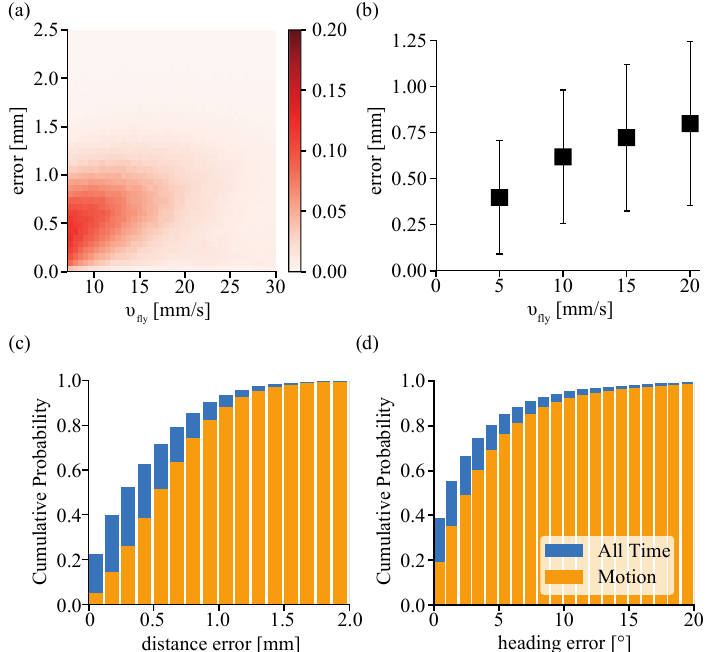
Figure 10. The performance of the TOLC. ( a ) The relationship between the distance error and the velocity of a walking fly. ( b ) The average error distance error for every 5.08 mm/s. The data point and bar represent the mean value and standard deviation. ( c , d ) The cumulative probability distribution of ( c ) the position error and ( d ) the heading error. The error data for entire experiments show as a blue bar, and those while a fly is in motion shows as an orange bar. We assumed that a fly is walking when its velocity is over >5.08 mm/s. The total experiment time is approximately 270 min across 20 flies and about 3.24 million images are processed in total.